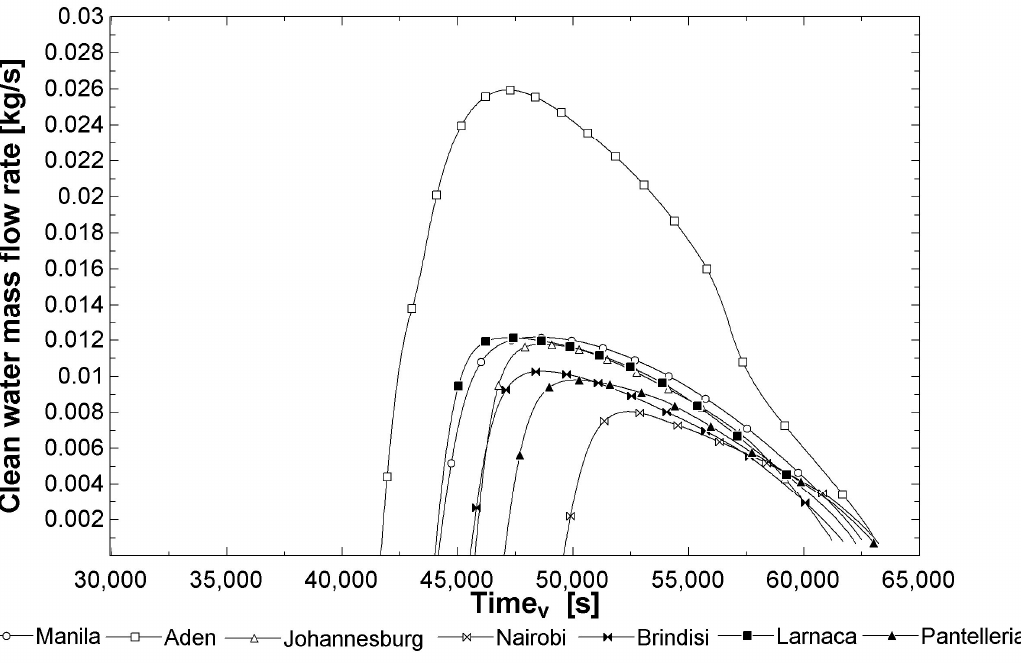
Figure 3. Clean water mass flow rate in the average day of May in various locations.